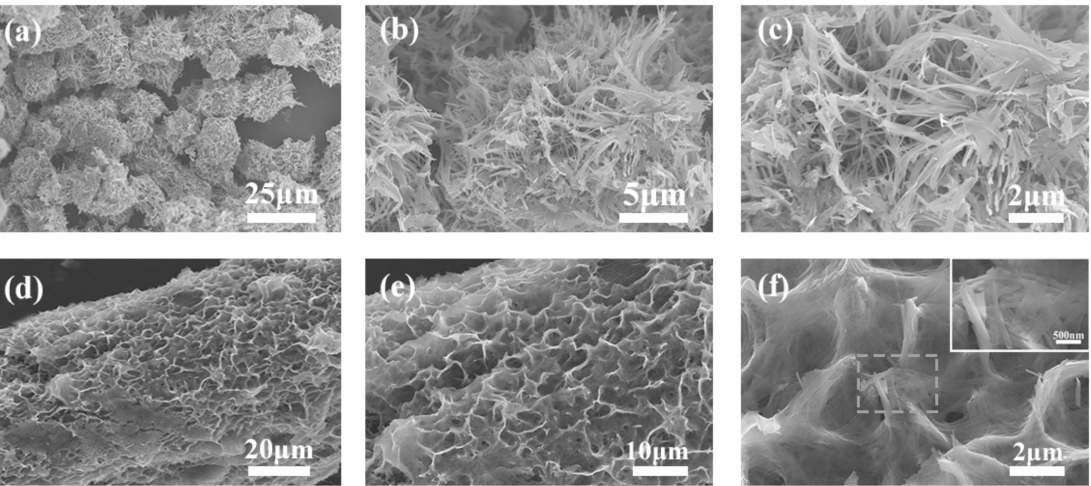
Figure 2. Scanning electron microscope (SEM) images; ( a – c ) the SEM images of NH 4 V 4 O 10 pow- der with different magnification; ( d – f ) the SEM images of NH 4 V 4 O 10 @CNT fiber with different magnification.